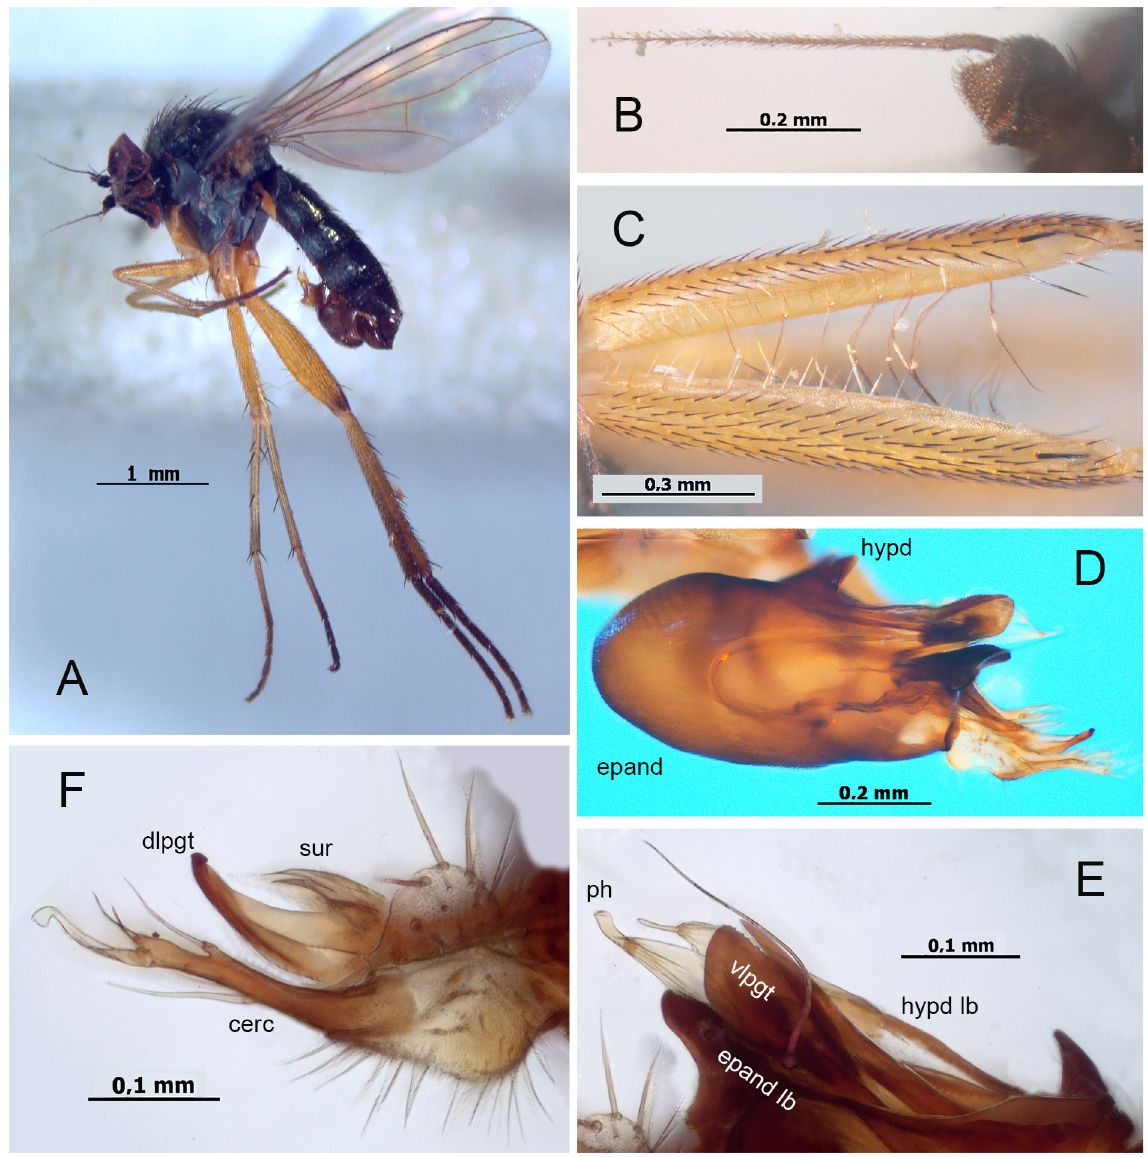
Fig. 1. Hercostomus brandbergensis sp. nov., ♂, paratype (NMNW). A . Habitus. B . Antenna. C . Mid femora, anterior view. D . Hypopygium, right lateral view. E . Distoventral appendages of epandrium. F . Cercus, surstylus and distal lobe of